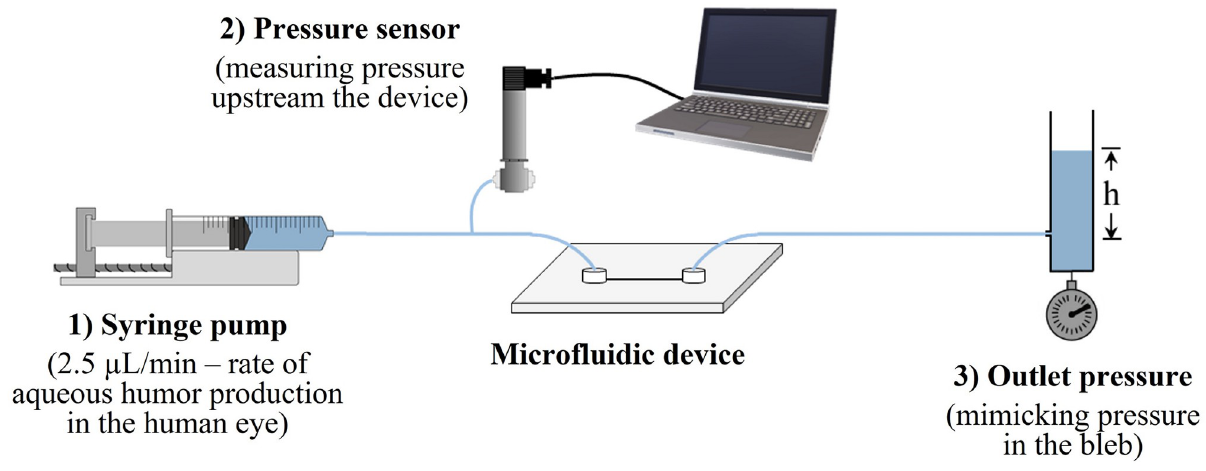
Fig 6. Setup used for the microfluidic